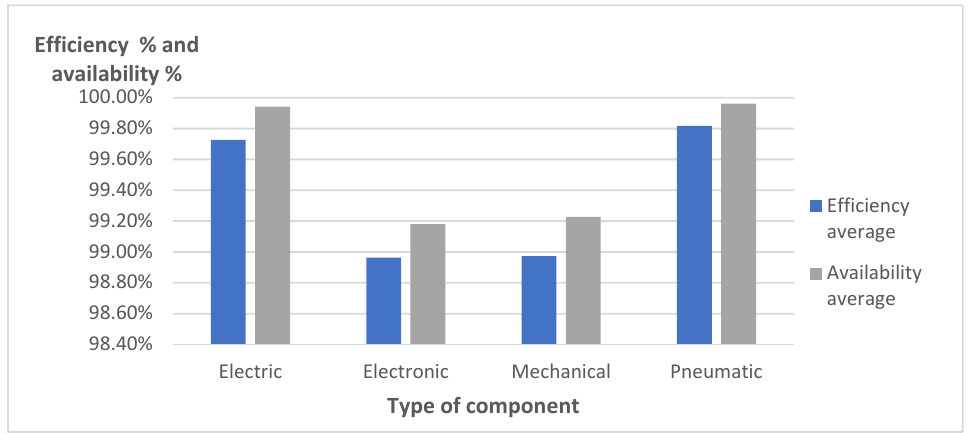
Figure 5. Average efficiency and availability values in % by component type with the IPPM strategy.